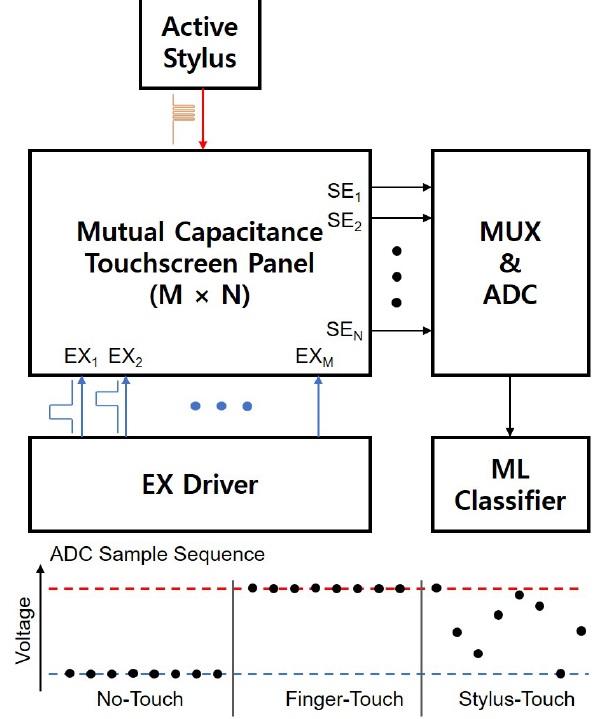
Figure 17. ML-based touchscreen scheme. The higher frequency pulses of a stylus generate the different sequence from finger-touch and no-touch, and three touches are discriminated by ML-based classifiers.